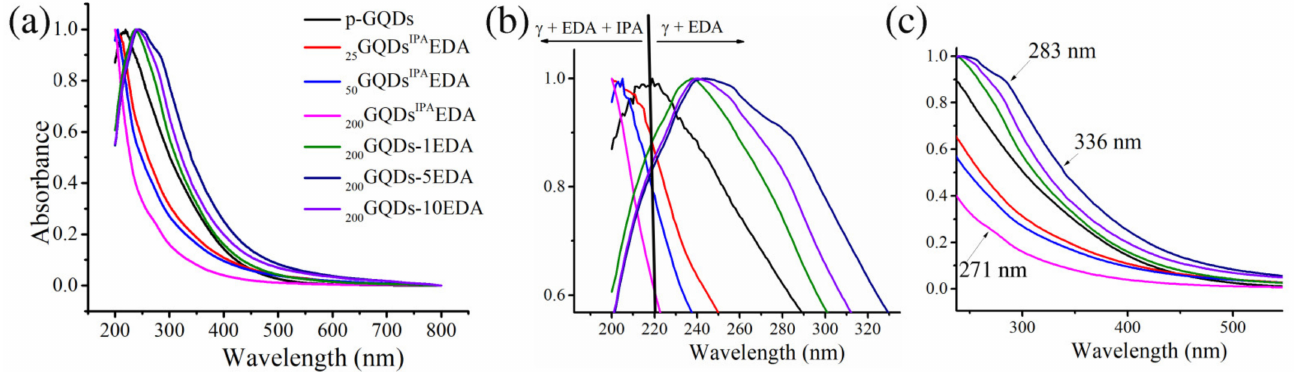
Figure 1. UV/Vis spectra of p-GQDs, 25 GQD IPA -EDA, 50 GQD IPA -EDA, 200 GQD IPA -EDA, 200 GQD-5EDA, and 200 GQD-10EDA ( a ); enlarged low-wavelength regions: 200–300 nm ( b ) and 250–500 nm ( c